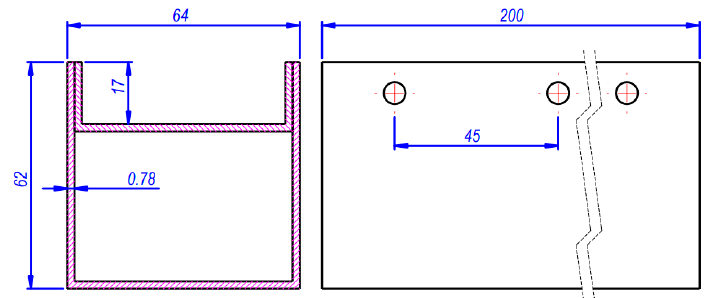
Figure 9. Specimen T1 measurements and spot-welded joint layout sketch.